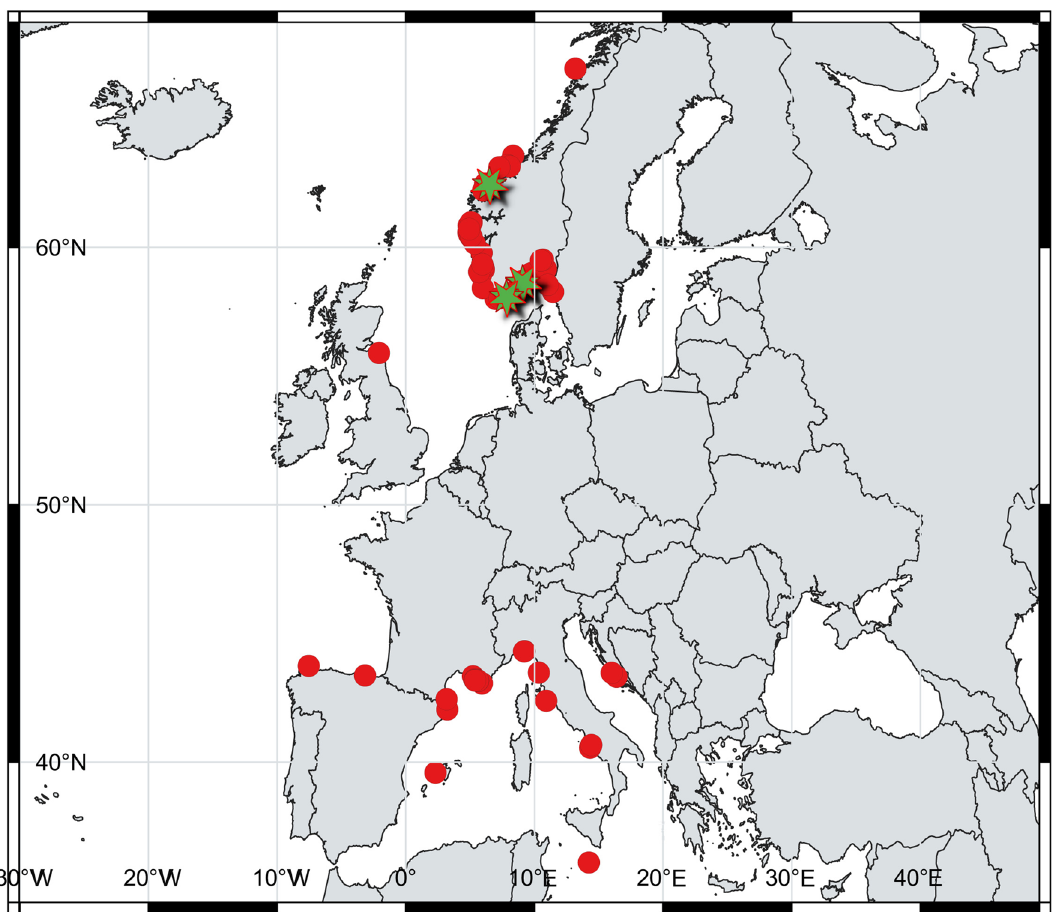
Figure 1. Locations where huge gelatinous spheres have been observed in the NE Atlantic Ocean, including the Mediterranean Sea (red dots), combining data from this study and Ringvold and Taite ( 1 , Fig. 2). Locations of DNA tested spheres (green stars). Figure generated with Qgis 3.2. (www. qgis. org) (Credit: Halldis Ringvold/Sea Snack